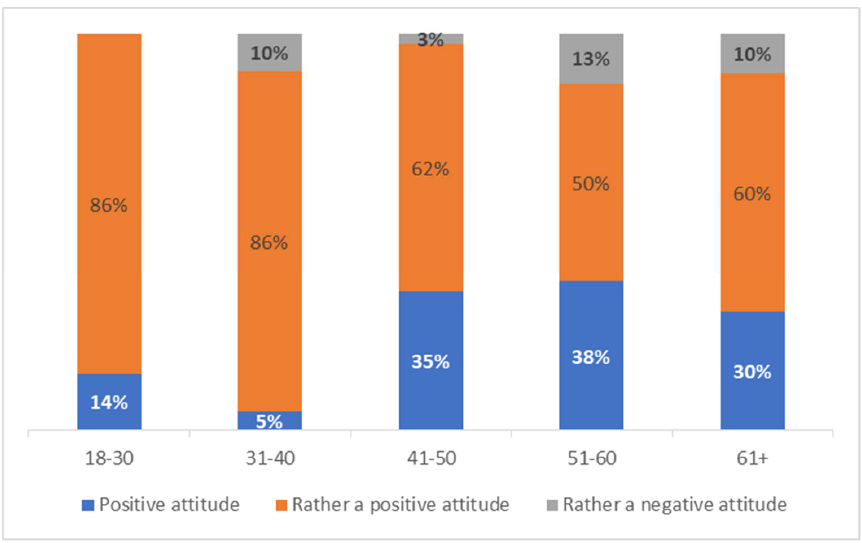
Figure 5. What is your attitude towards technologies? (Age distribution). N = 99.